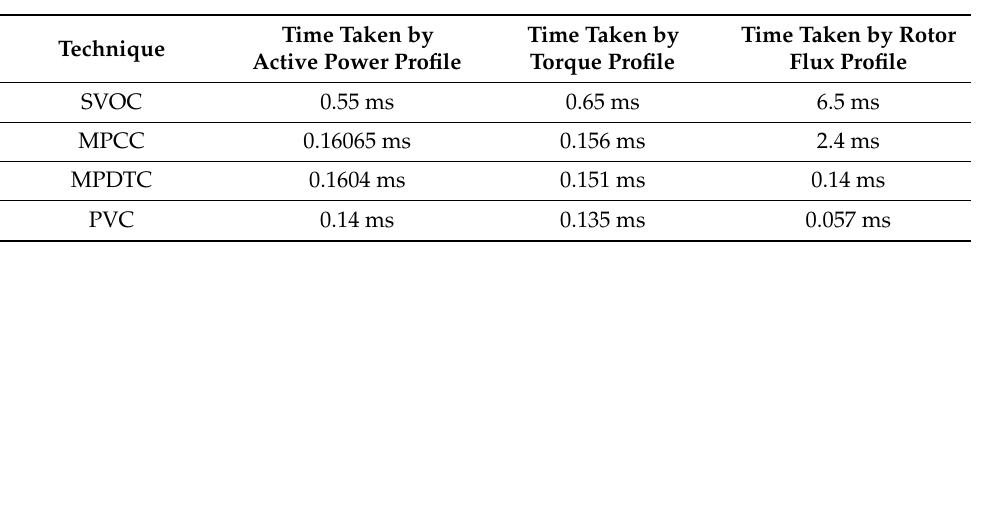
Figure 195. Embedded code for calculating the number of commutations for predictive controllers. Table 1. Response time taken by the actual values to reach to their references values in 2nd